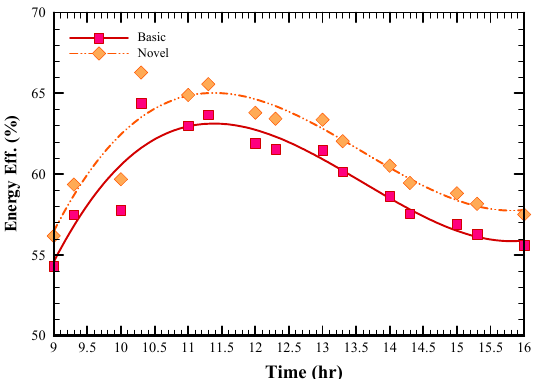
Figure 10. Variation of energy efficiency for a basic system without a turbulator and novel PTSC equipped with a turbulator and filled with nanofluid at ϕ = 0.019% and Re = 5000 versus different times of day.